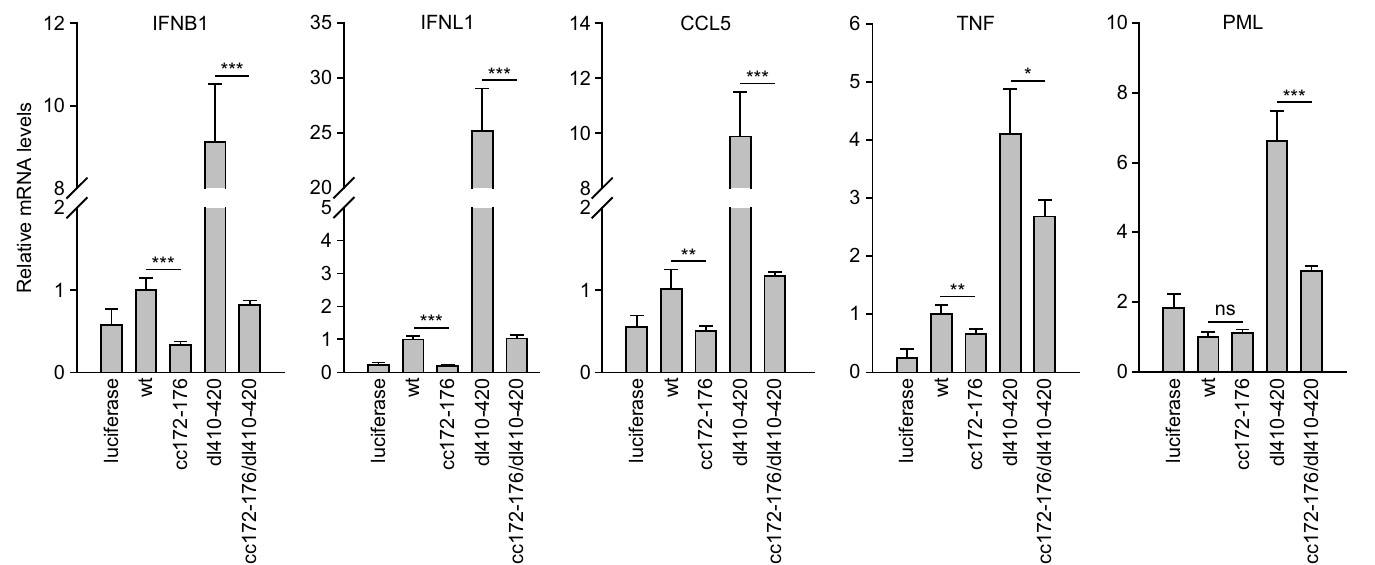
Fig 9. Reduced cytokine and ISG expression during hCMV infection due to lack of IE1-PML interaction. TetOne cells expressing firefly luciferase and TetOne-IE1 cells expressing the indicated HA-tagged wild-type (wt) or mutant IE1 proteins were treated with dox for 48 h and infected with gTBdlIE1 at an MOI of 2 PFUs/cell for 6 h. Relative mRNA levels were determined by RT-qPCR for the indicated cytokine genes (IFNB1, IFNL1, CCL5, TNF) and PML. Results were normalized to TUBB, and means and standard deviations of three biological and two technical replicates are shown in comparison to cells expressing wt IE1 (set to 1). Statistical significance was assessed in Excel using a two-tailed, unpaired T-test; ns, not significant; � , p < 0.05; �� , p < 0.01; ��� , p < 0.001.